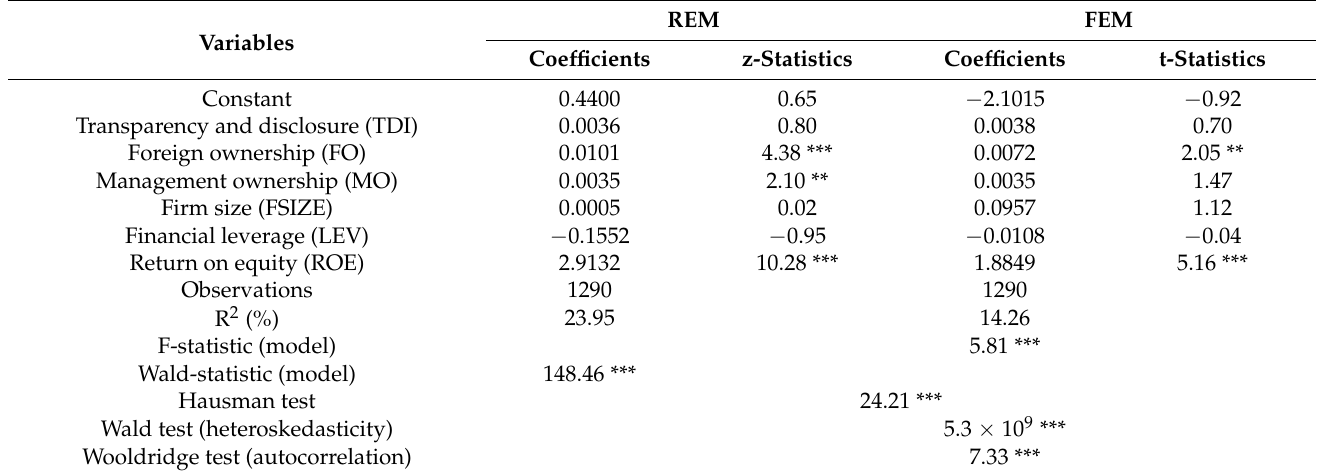
Table 3. Estimated results of the REM and FEM models.